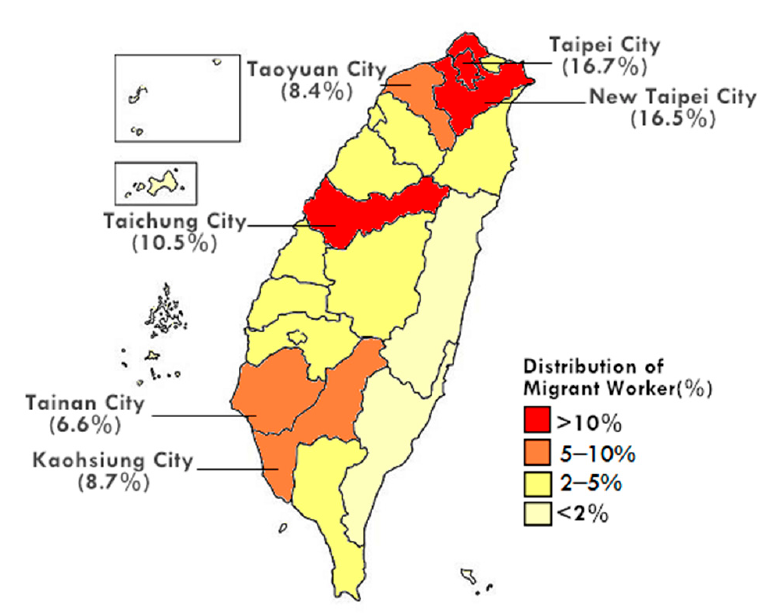
Figure 1. The percentage of migrant workers in social welfare by region in November 2021 [1]. Data source: adapted from https://english.mol.gov.tw/21004/21107/21113/lpsimplelist (accessed on 30 January 2022).